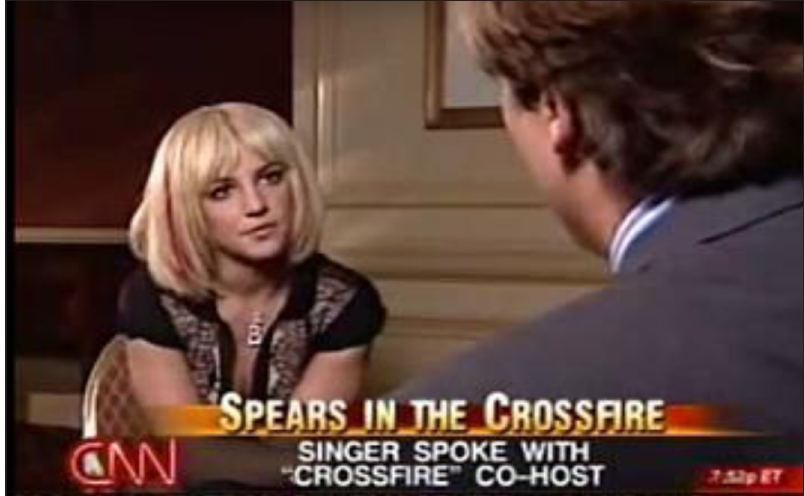
Figure 2: Britney on CNN’s “Crossfire”, September 3,